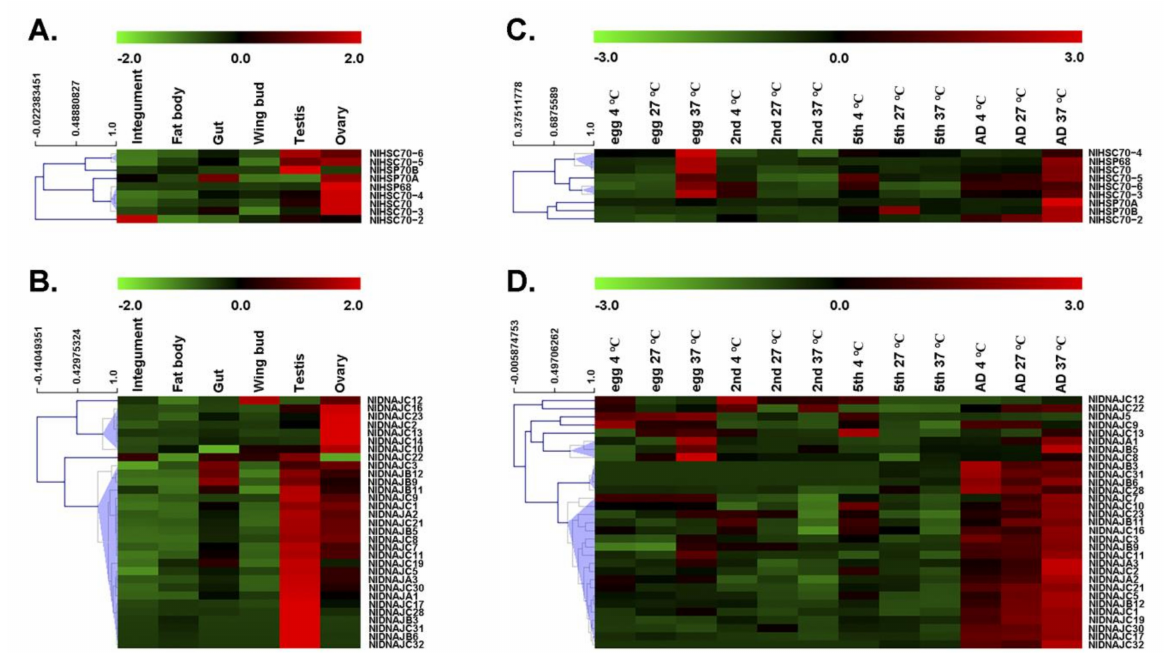
Figure 4. Spatio-temporal expression patterns of NlHSP70 and NlDNAJ genes. ( A , C ) Tissue expression patterns of NlHSP70 and NlDNAJ genes. Total RNAs were isolated from the integument, fat body, gut, ovary, and testis of BPH. ( B , D ) Developmental profiles of NlHSP70 and NlDNAJ genes at different temperatures. Total RNAs were isolated from eggs, 2nd instar, 5th instar nymphs, and adults at 24 h after molting under 4 ◦ C, 27 ◦ C, and 37 ◦ C for 1 h. RT-qPCR and the ∆∆ Ct method were utilized to measure the relative transcript levels. The heatmap was created using the MultiExperiment Viewer (MeV)